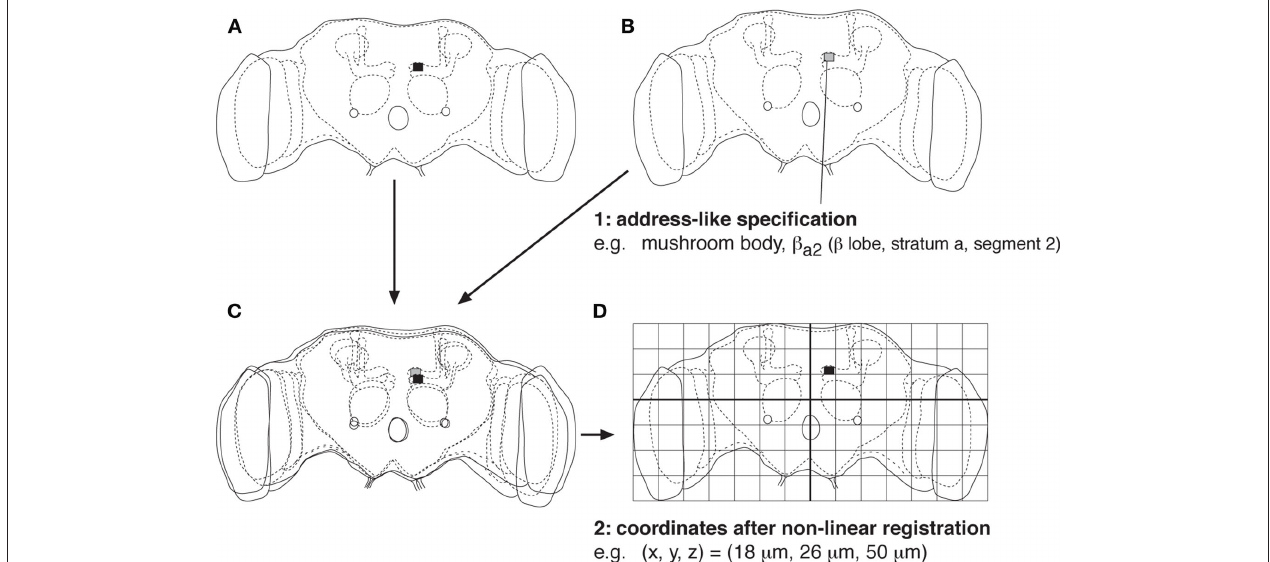
affine transformation. Best match cannot be attained, because individual brain region may have slightly different size, shape, and orientation. (d) Comparison of the two brain samples after non-linear registration (so-called morphing or warping). All the brain samples can be fit into a standardized framework, in which the position in the brain can be specified using